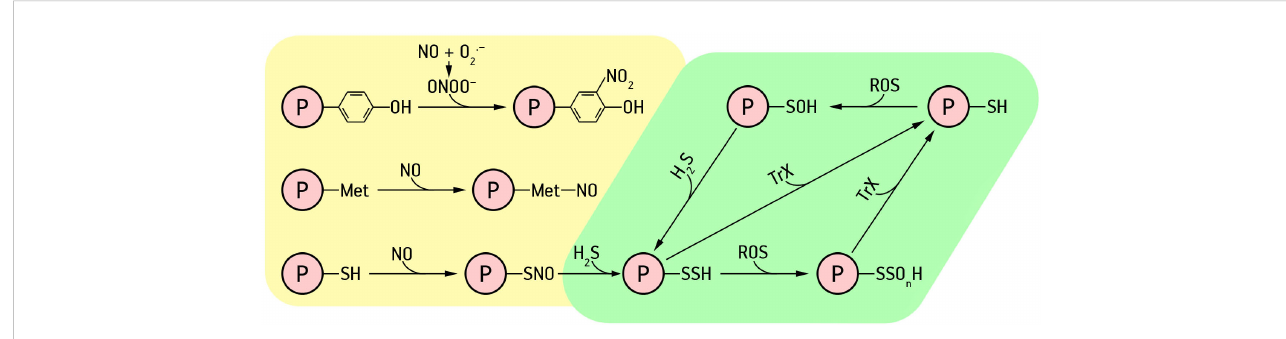
FIGURE 1 Post-translational modi fi cations of proteins by the action of hydrogen sul fi de and nitric oxide. Explanations in the